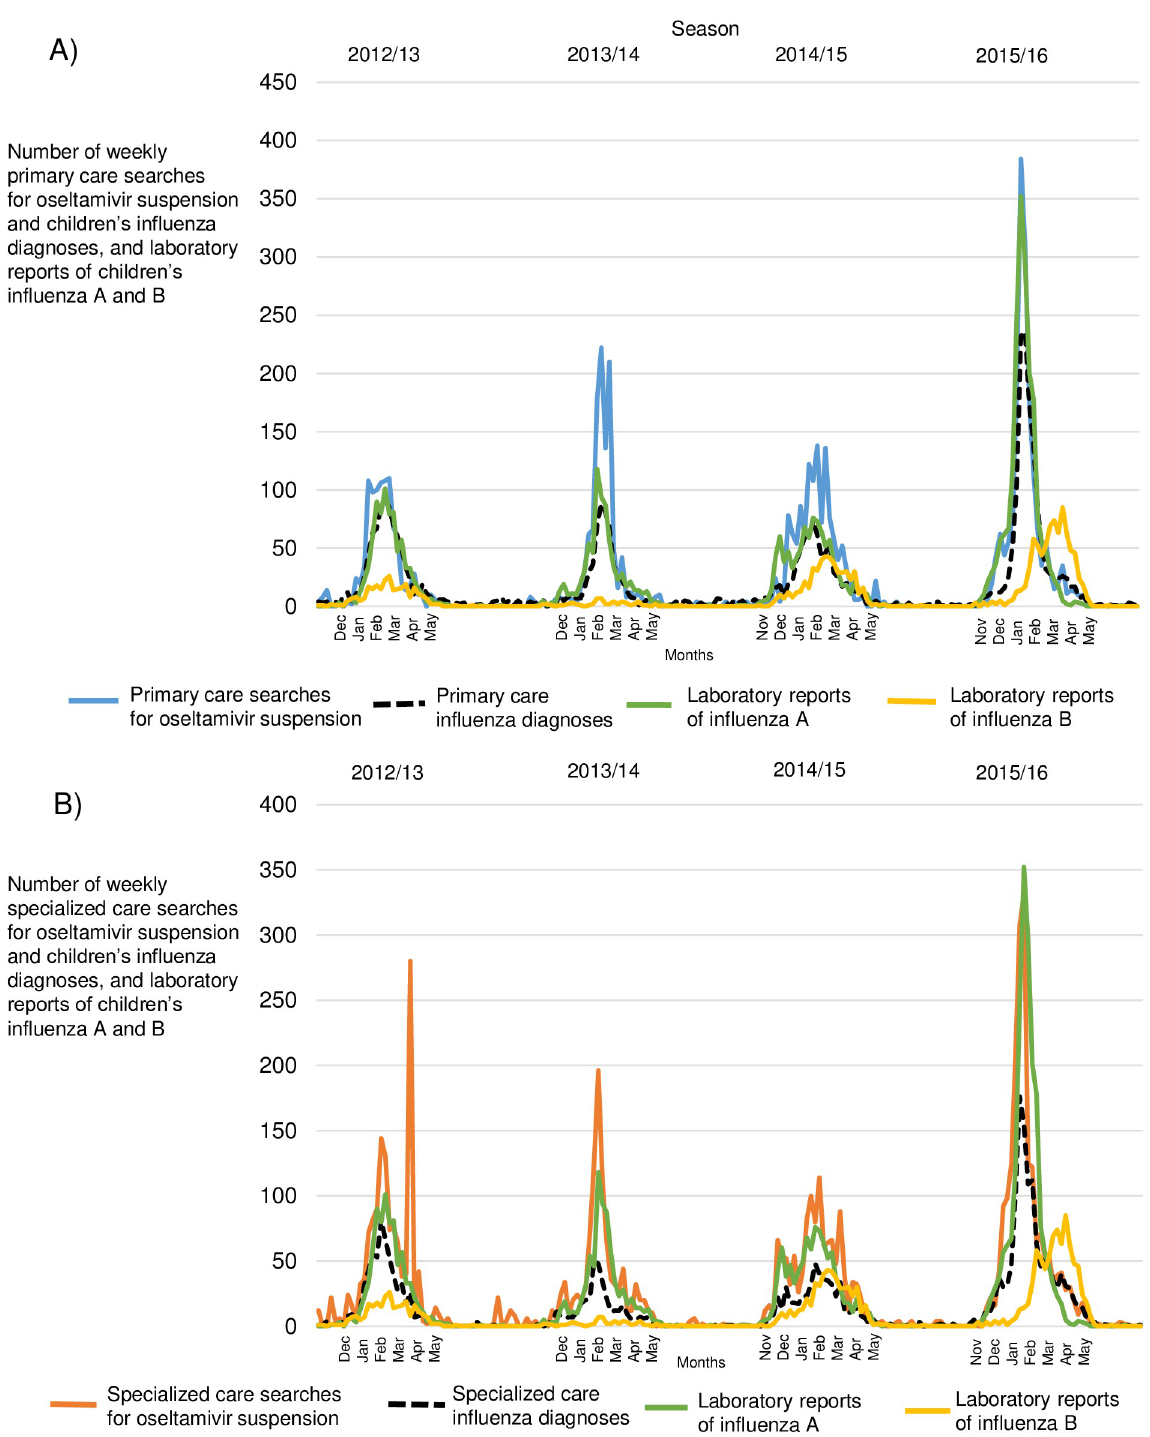
Fig 1. Oseltamivir searches, influenza diagnoses, and laboratory reports of children’s influenza A and B across Finland during 2012–2016 by season. (A) Searches for oral suspension of oseltamivir and children’s influenza diagnoses in primary care. (B) Searches for oral suspension of oseltamivir and children’s influenza diagnoses in specialized